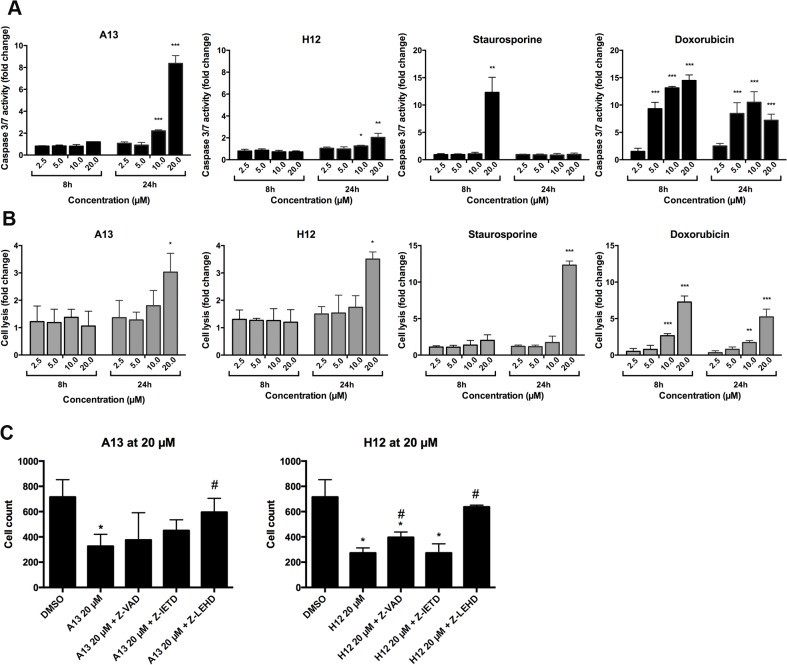
Induction of caspase 3 and 7 activity and cell lysis in U2OS cell line after compound treatment.A) shows caspase 3/7 activity and B) cell lysis for U2OS cell line treated with increasing concentrations of compound A13, H12, staurosporine and doxorubicin, respectively. Caspase 3/7 activity was determined after 8 and 24h of treatment using Caspase-Glo 3/7 Assay. Cell lysis was determined using CellTox Green Cytotoxicity Assay. Data are shown as fold change of mean +/- SD from duplicates of two independent experiments relative to DMSO-treated control. Unpaired t test was performed versus DMSO-treated control with *p < 0.05, **p < 0.01, and ***p < 0.001. C) shows cell count determined by quantification of Hoechst-stained nuclei after treatment of HOS cells with 20 μM of compound A13 and H12, respectively, and after co-treatment of cells with compounds and caspase inhibitors (pan-caspase inhibitor Z-VAD-FMK, caspase 8 inhibitor Z-IETD-FMK or caspase 9 inhibitor Z-LEHD-FMK) for 24h. Means and SD from duplicates of one representative experiment of two are shown (*p < 0.05 versus DMSO treated control; #p < 0.05 versus cells treated with 20 μM of compound).